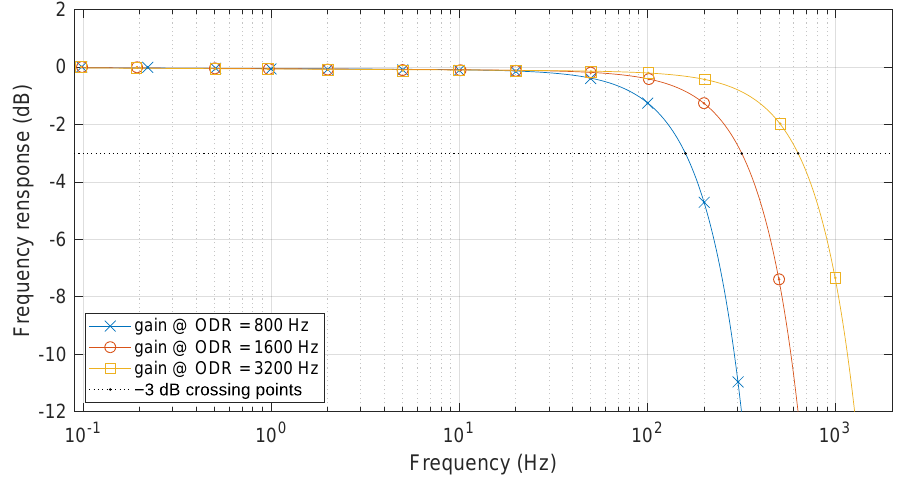
Figure 9. Measured frequency response of the EMG signal path, with the output data rate set to 800 Hz, 1600 Hz, and 3200 Hz (markers denote measured data points, solid lines are interpolated).